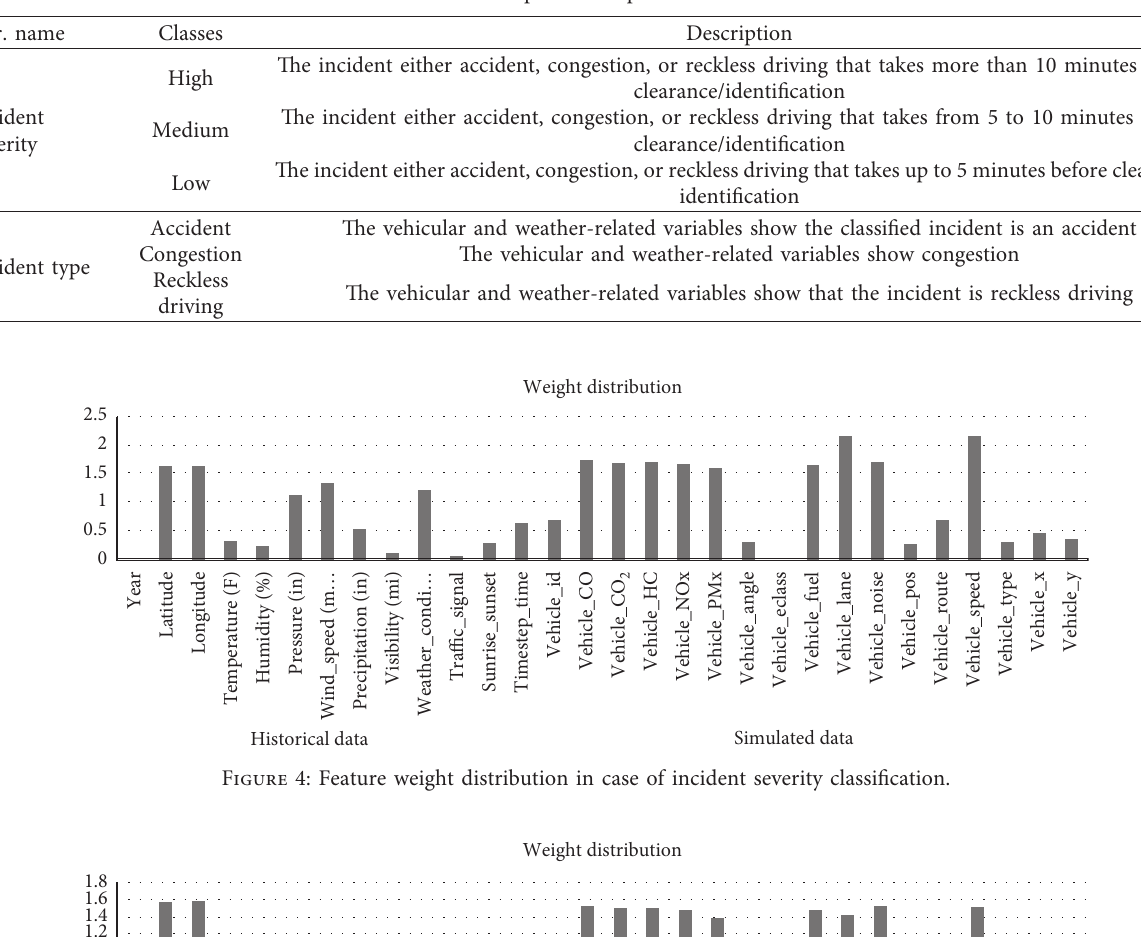
Table 5: Description of dependent variables.